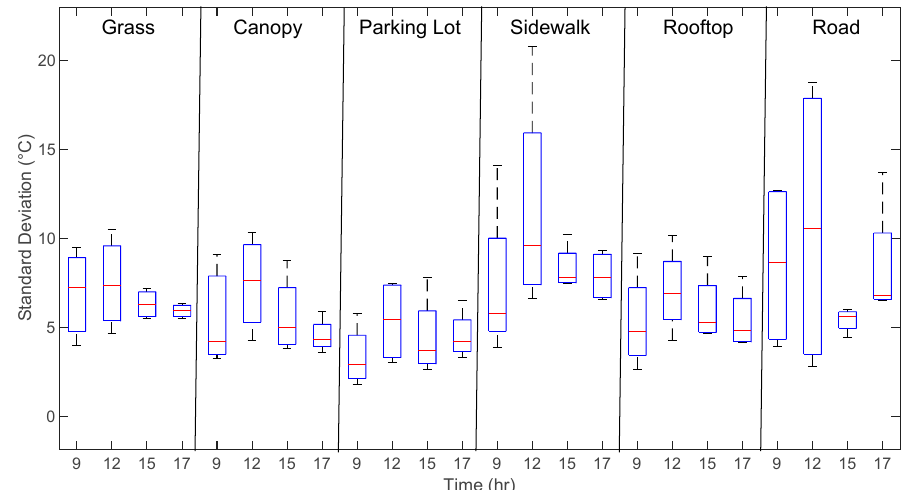
Figure 5. Standard deviation distributions for six land use types at hour 9, 12, 15 and 17 at both the MU and UTEP locations.